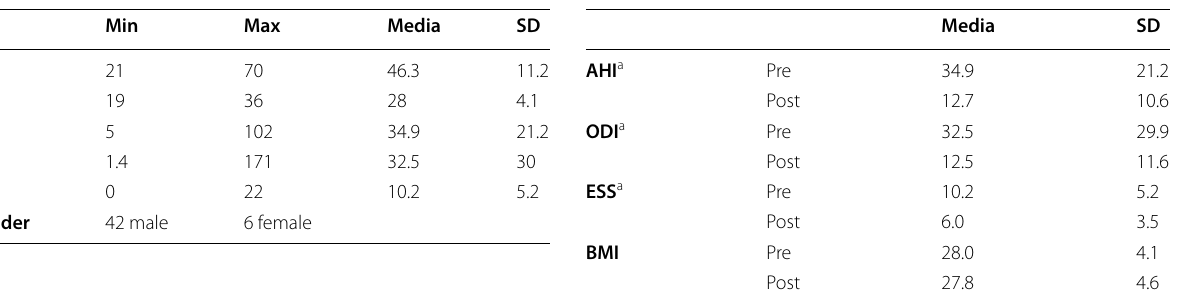
Table 1 Demographic data